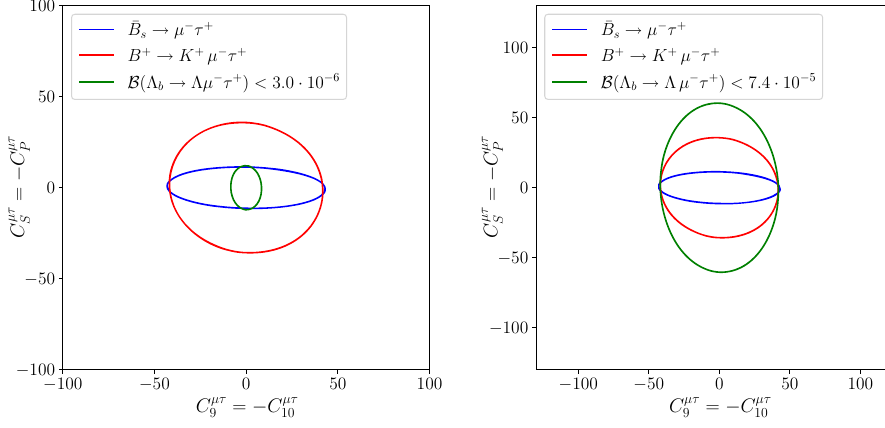
Fig. 3 Illustration of the orthogonality between current mesonic and possible future baryonic